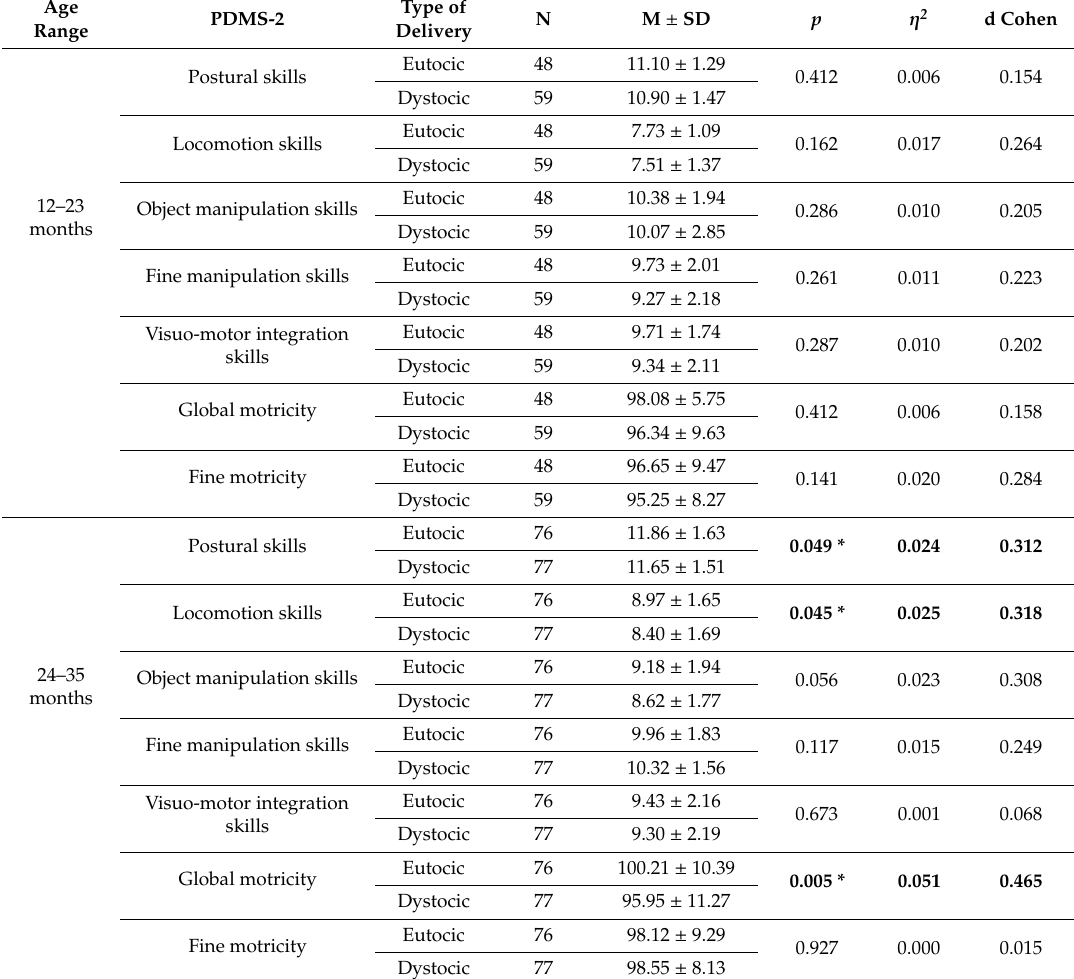
Table 4. Di ff erences between the type of delivery in the PDMS-2 for each age